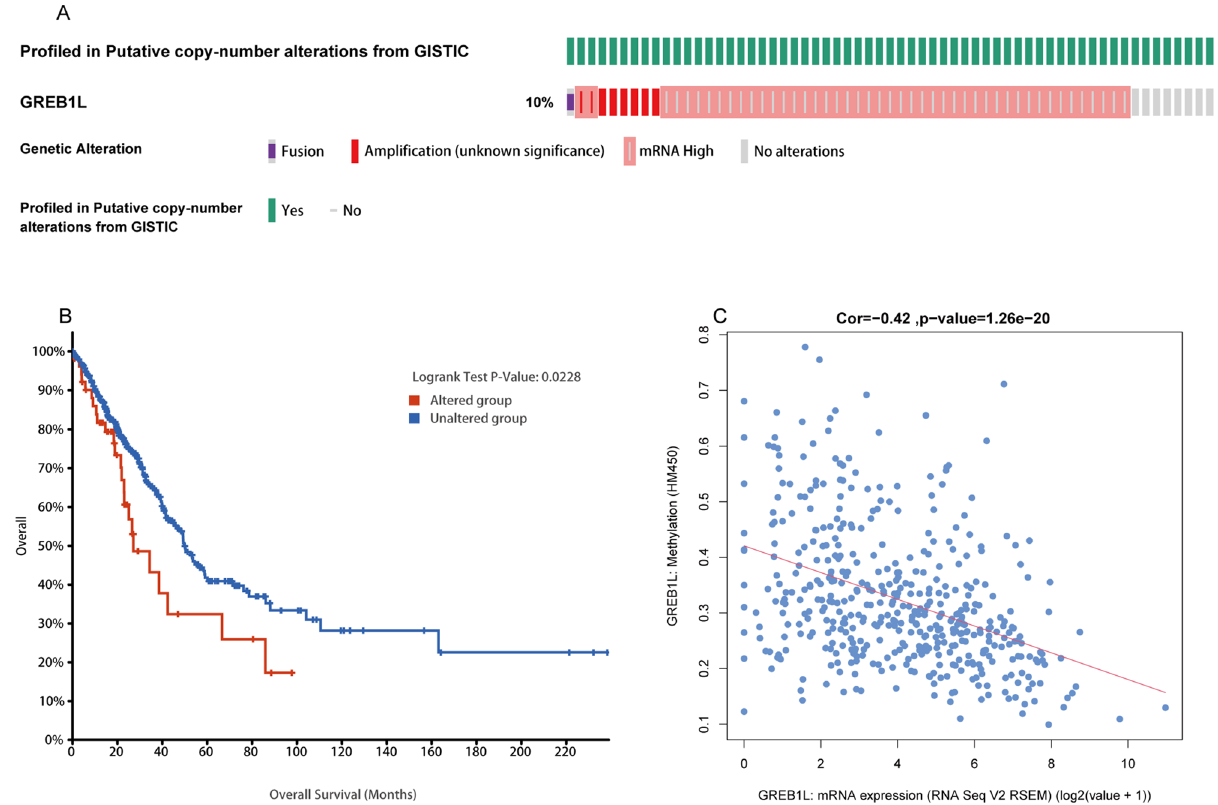
Figure 6. The gene alteration and methylation of GREB1L in LUAD. ( A , B ) Genetic alteration in GREB1L and its association with OS of LUAD patients; ( C ) The correlation between GREB1L methylation and its expression